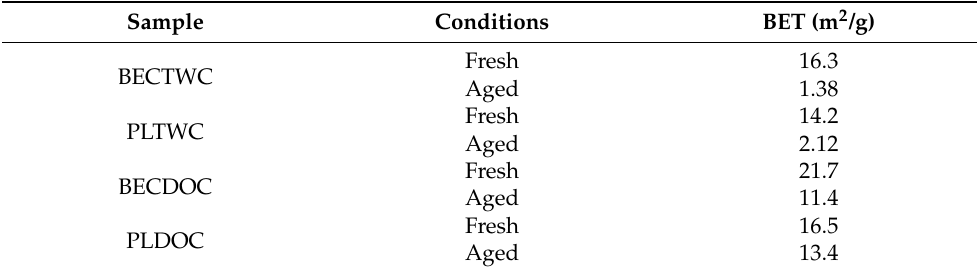
Table 3. Summary of the SSA measurements with the BET system.